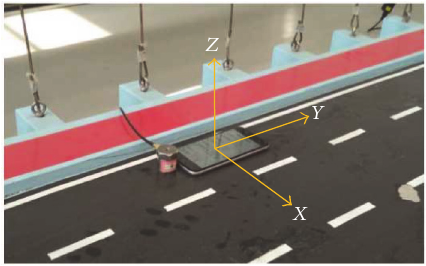
Figure 10: The reference coordinate system of smartphone.